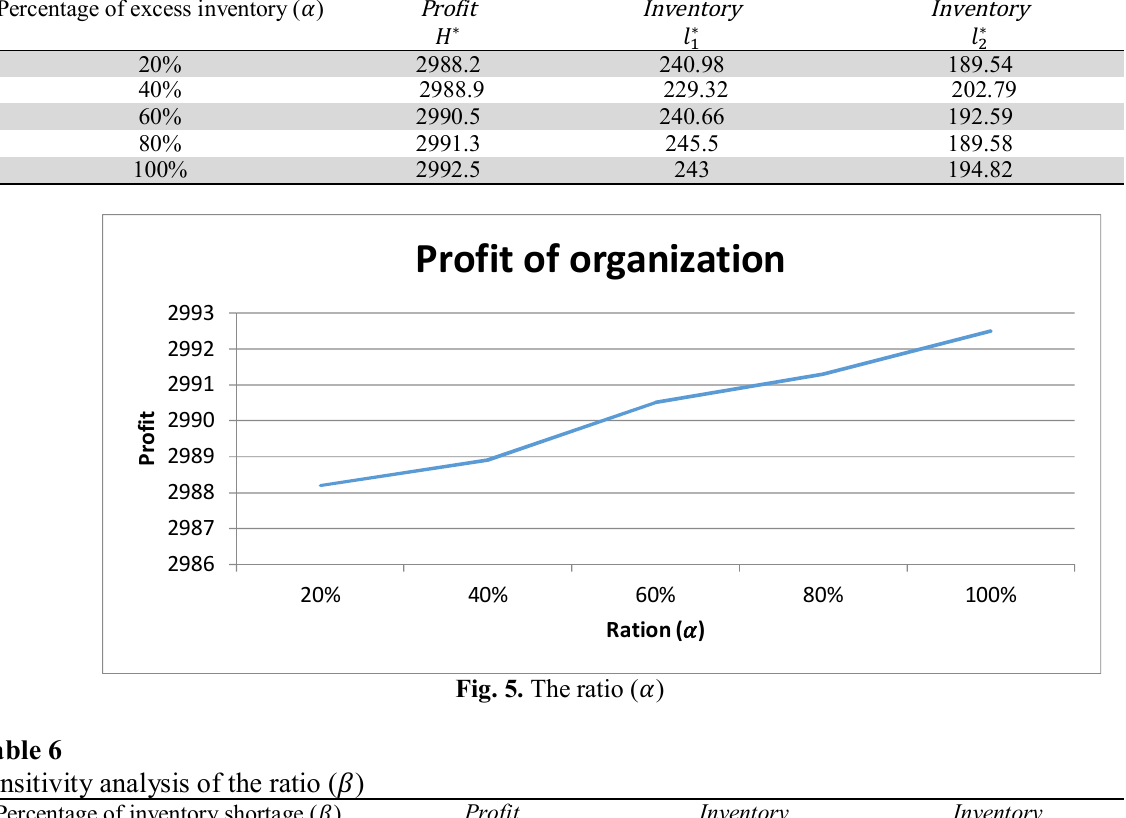
Percentage of excess inventory ( (cid:2009) )